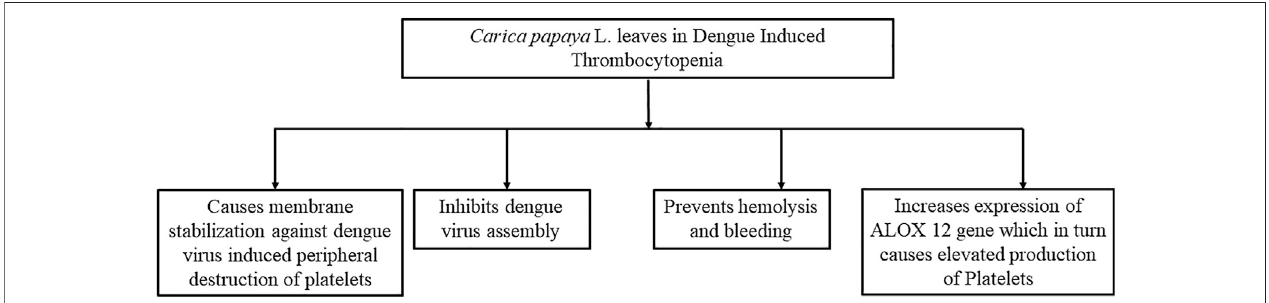
FIGURE7| Possiblemechanismsbehindtheroleofpapayaleavesinimprovingplateletcount.This fi guresummarizesthemechanismofpapayaleavesinreducing thrombocytopenia by the dengue virus. It stabilizes the membrane of platelets and reduces platelet destruction. It also prevents viral assembly in cells and hemolysis. Furthermore, it increases the expression of genes that elevate the production of platelets.